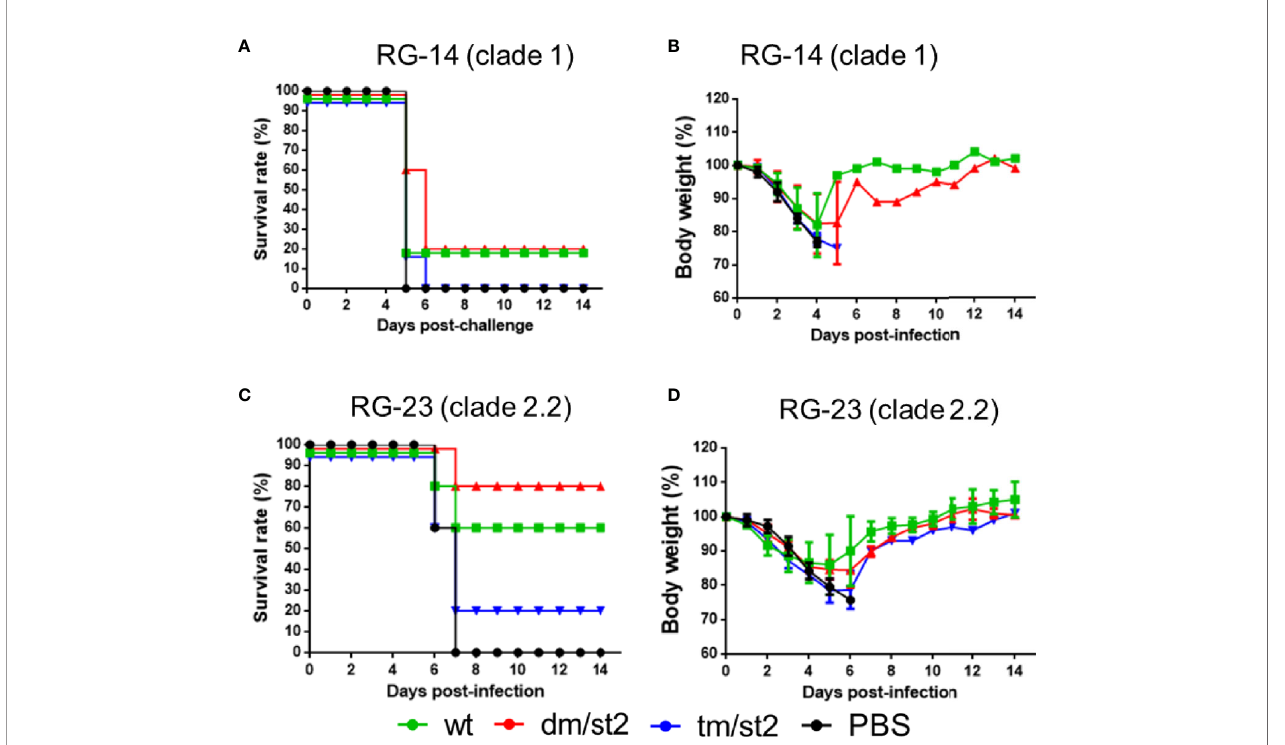
FIGURE 6 | Protective immunity against homologous and heterologous H5N1 virus challenges. Four groups of mice immunized with rH5 + rH5 regimen, or alone with the PBS control were challenged with 10-fold of the 50% mouse lethal dose (MLD50) of the homologous RG14 (clade 1) or the heterologous RG ‐ 23 (clade 2.2) H5N1 viruses. (A) Survival rates of mice challenged with RG14 (clade 1) H5N1 virus. (B) Body weights of mice challenged with RG14 (clade 1) H5N1 virus. (C) Survival rates of mice challenged with RG ‐ 23 (clade 2.2) H5N1 virus. (D) Body weights of mice challenged with RG ‐ 23 (clade 2.2) H5N1